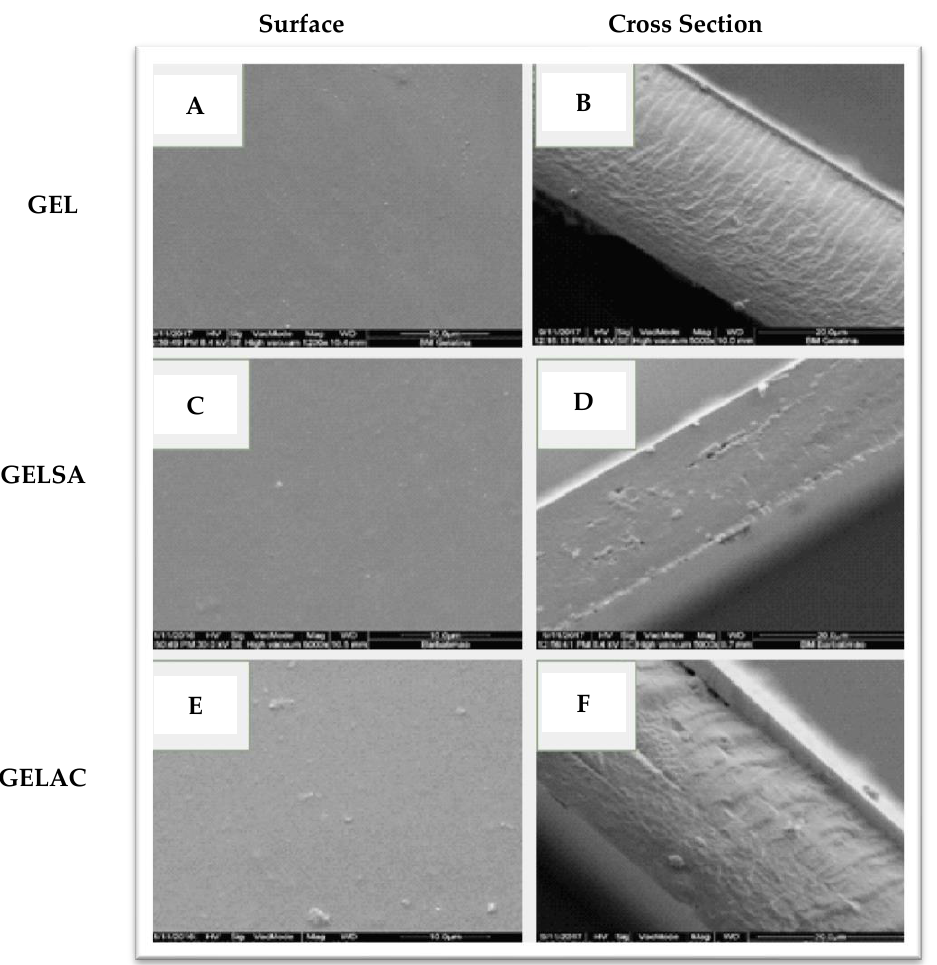
Figure 6. Surface and cross-section micrographs of the GEL ( A , B ), GELSA ( C , D ), and GELAC ( E , F ) biomembranes.